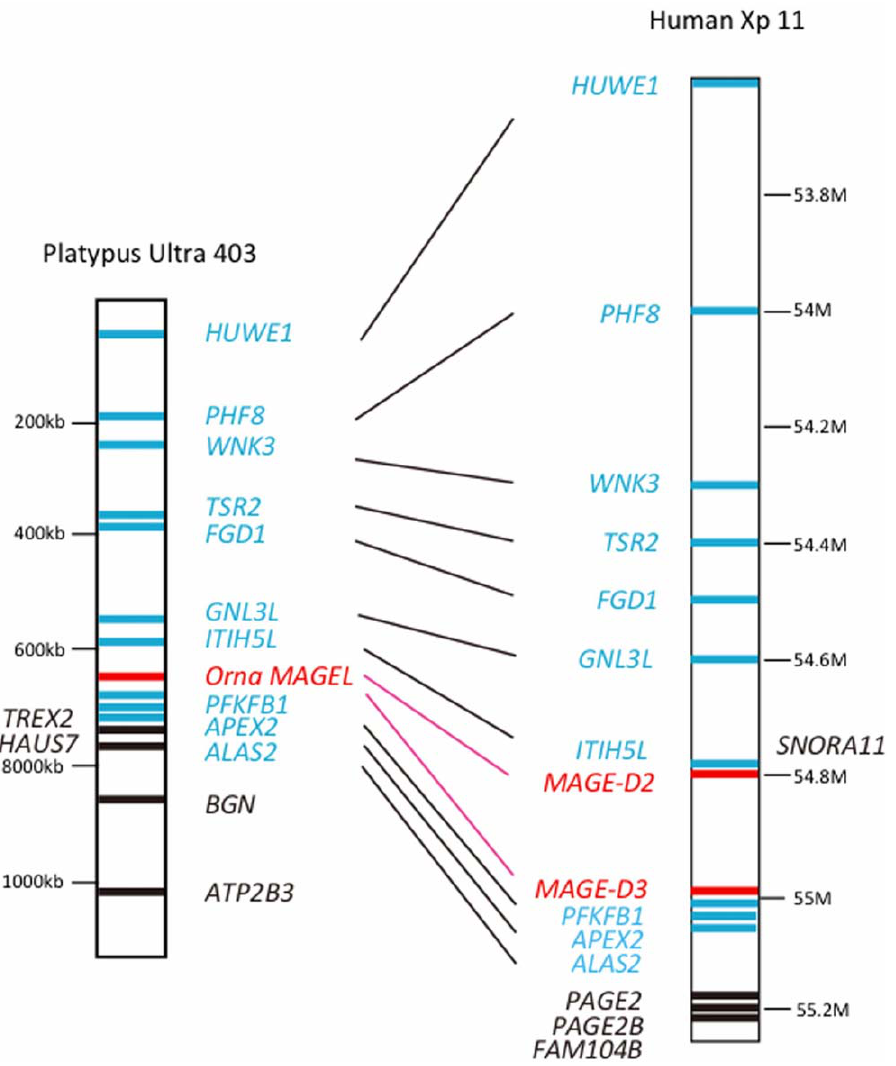
Figure 2. Synteny between platypus contig Ultra 430 and human X chromosome Xp11. Red bars indicate MAGE-D or MAGEL genes in the human or platypus, respectively. Black bars and gene names indicate syntenic genes between humans and platypuses. Blue bars and gene names indicate genes that do not show synteny. Other MAGE-D subfamily members, MAGE-D1 and MAGE-D4 are located at 51.6 M and 51.9 M on the human X chromosome,